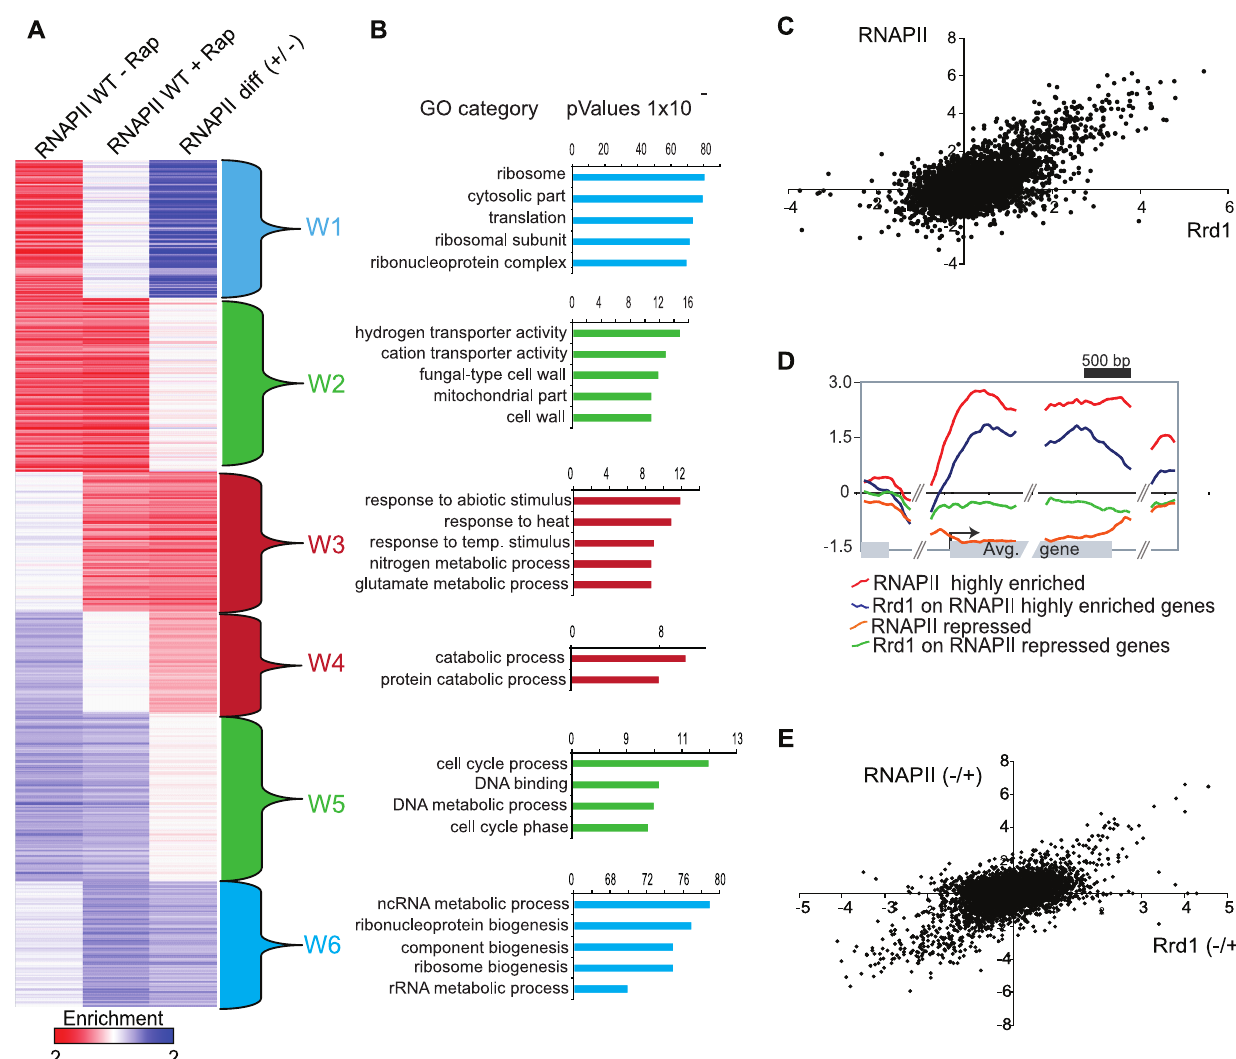
Figure 2. Rrd1 localization correlates with RNAPII along actively transcribed genes. ( A ) Self-organizing map (SOM) clustering analysis of the median enrichment of RNAPII on all ORFs from the WT strain. The red colour indicates enriched (bound) regions and blue colour represents depleted regions. The difference (diff ( + / 2 )) (right column) was calculated by subtracting the complete untreated ( 2 RAP) RNAPII data set (left column) from the treated ( + RAP) RNAPII data set (middle row) (RAP=rapamycin 100 ng/ml for 30 min). The brackets (W1–W6) indicate clusters that were analyzed by gene ontology (GO). ( B ) Functional annotation of cluster W1–W6 with representative GO groups is shown. Funcassociate 2.0 was used to generate the full GO analysis, available in supplemental file S1. The X- axis represents the P-value. ( C ) Linear correlation of RNAPII and Rrd1- Myc enriched genes under normal growth condition. Each dot represents a single gene containing the median enrichment value from RNAPII on the y-axis and the Rrd1-Myc median enrichments on the x-axis. For the rapamycin treated data sets refer to supplemental figure S1A. ( D ) Mapping of RNAPII and Rrd1 on groups of genes with different median enrichment of RNAPII under normal growth conditions. The red line represents RNAPII along the 10% of genes with the highest amount of RNAPII and the blue line represents Rrd1 on this same group of genes. The orange line represents RNAPII on the lowest 10% RNAPII enriched genes and the green line represents Rrd1 on this same group of genes. ( E ) Linear correlation of RNAPII and Rrd1 gene occupancy differences between normal growth and rapamycin conditions. This is the same analysis as (C) only that the difference of the untreated and treated data set for the median enrichment of RNAPII and Rrd1 was plotted.